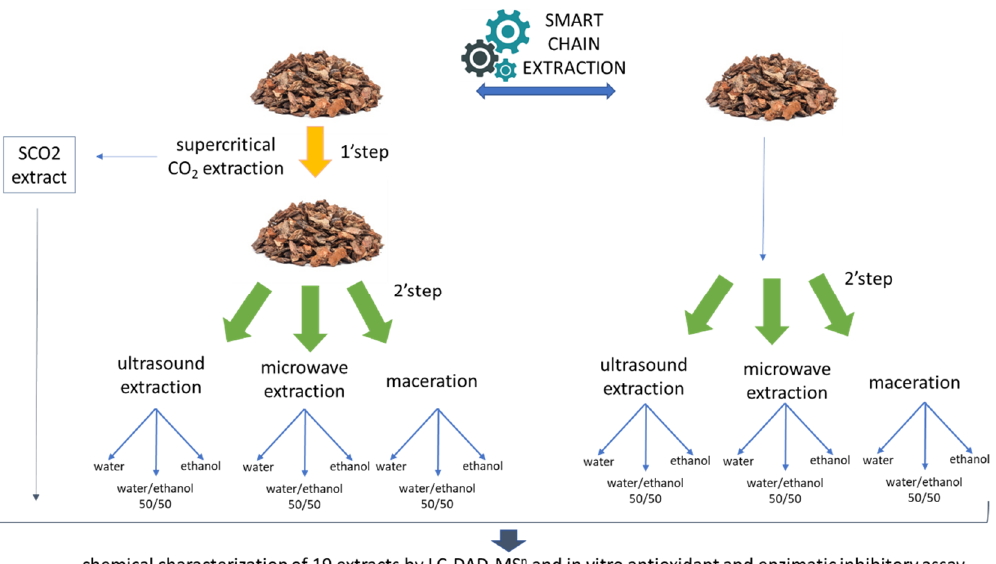
Figure 1. Scheme summarizing the different extraction processes studied in the paper.